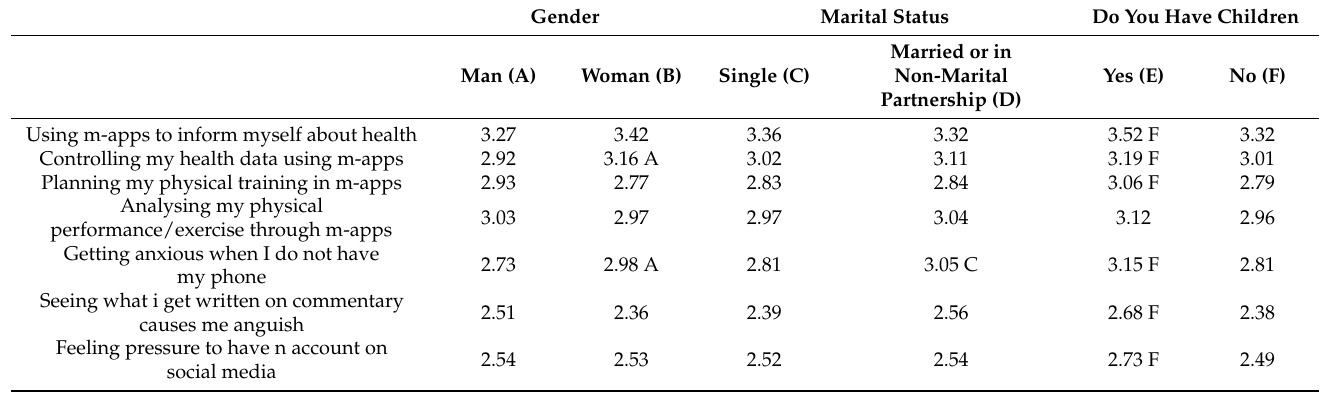
Table 6. Mean level of agreement of different personal experiences of Portuguese young adults